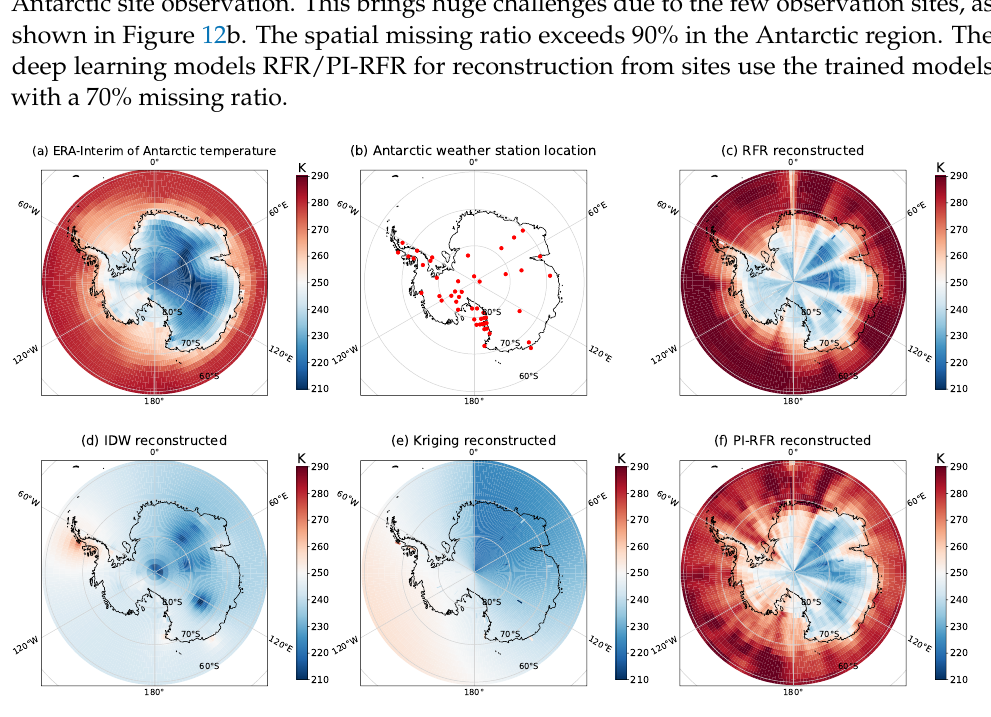
Figure 12. Reconstruction results of Antarctic station skin temperature data by IDW, Kriging, RFR and PI-RFR methods. The subfigure ( a ) is the data of the reanalysis data, and we take it as the ground truth. The subfigure ( b ) represents the location of the Antarctic weather station. The subfigures ( c – f ) show the reconstruction results of RFR, IDW, Kriging and PI-RFR,